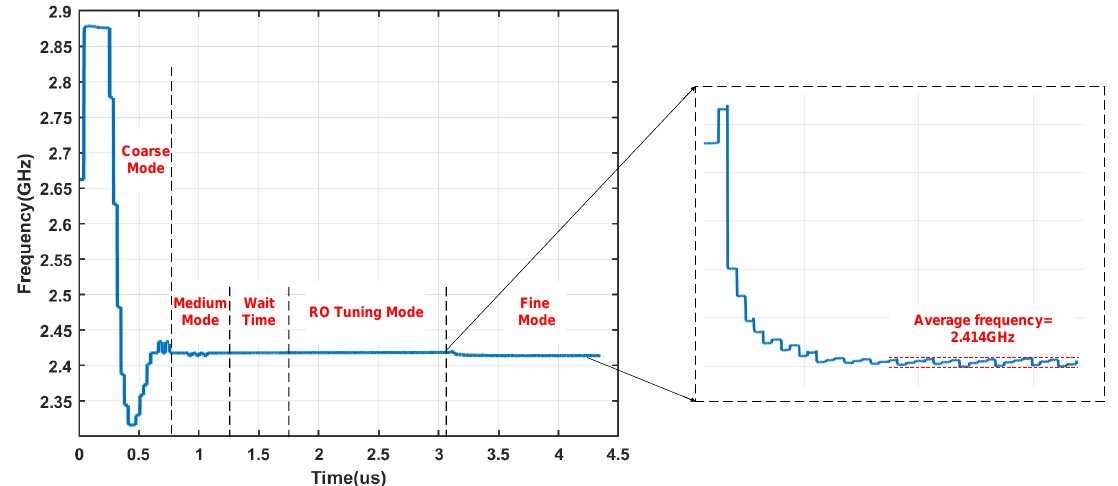
Figure 15. Transient waveform of the system operation with post-layout simulation.